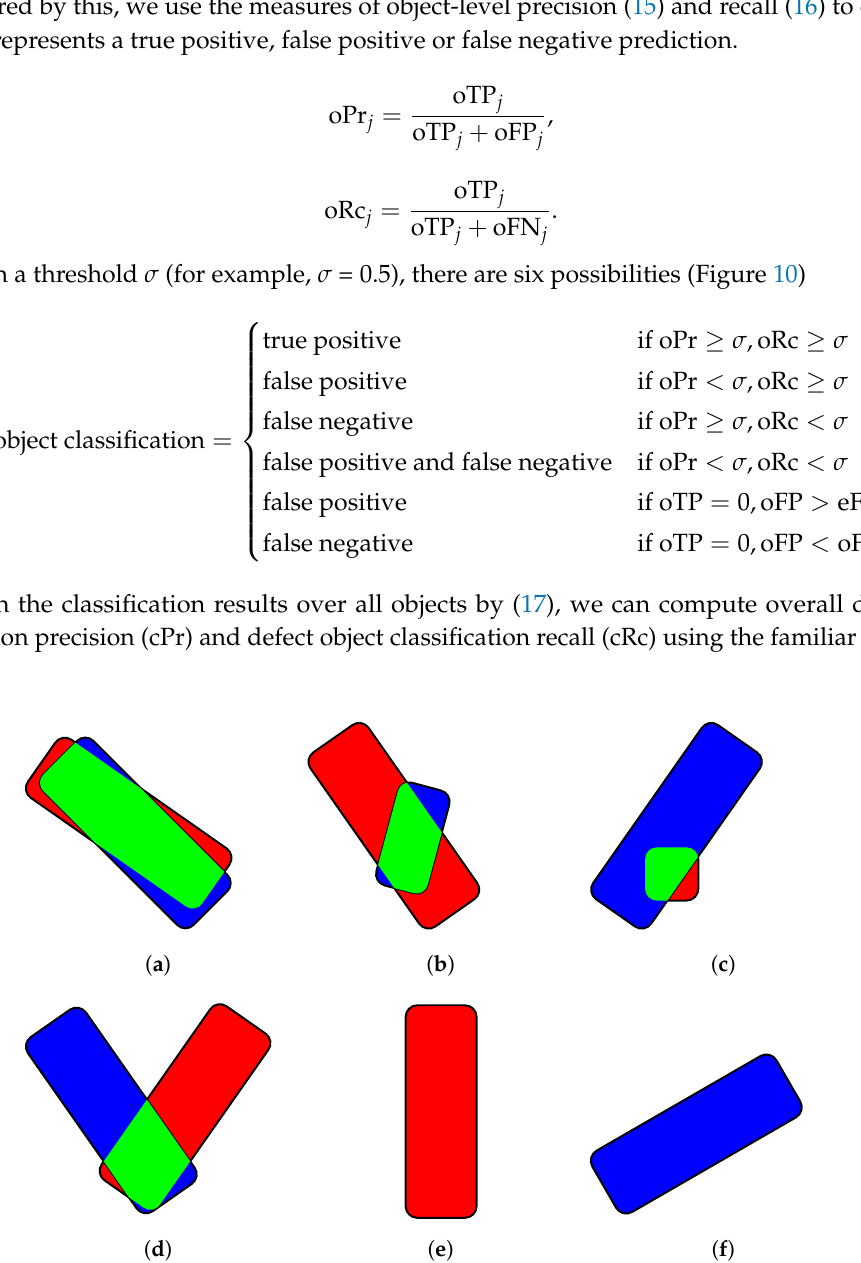
Figure 10. Classification of segmented defects. As in Figure 9, colors green, blue and red depict TP, FN and FP pixels, respectively. ( a ) true positive; ( b ) false positive; ( c ) false negative; ( d ) false negative and false positive; ( e ) false positive; ( f ) false